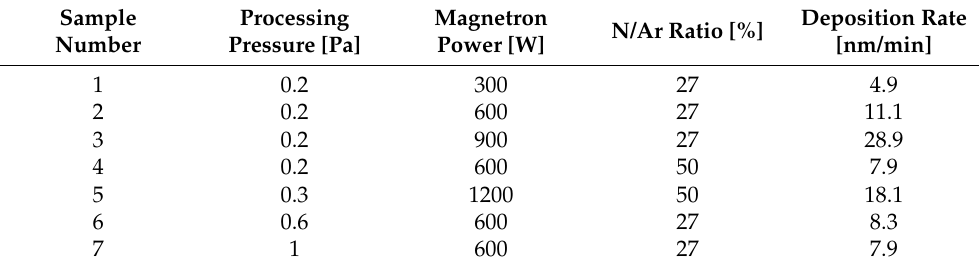
Table 1. Sputtering parameters and deposition rates for all produced